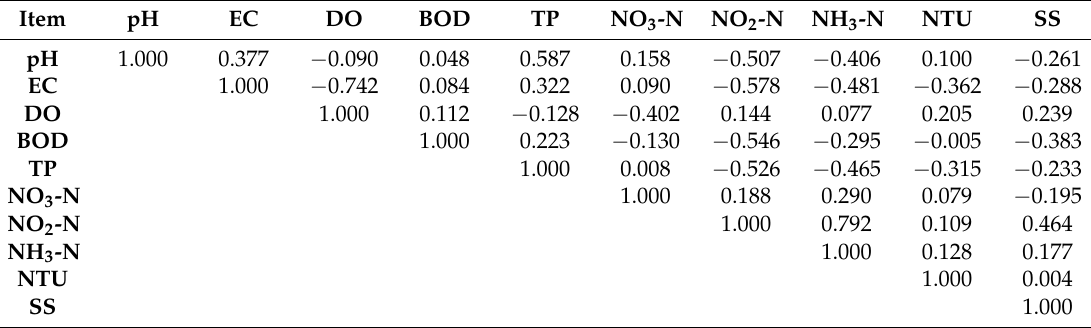
Table 5. Correlation coefficient matrix for each water quality index.